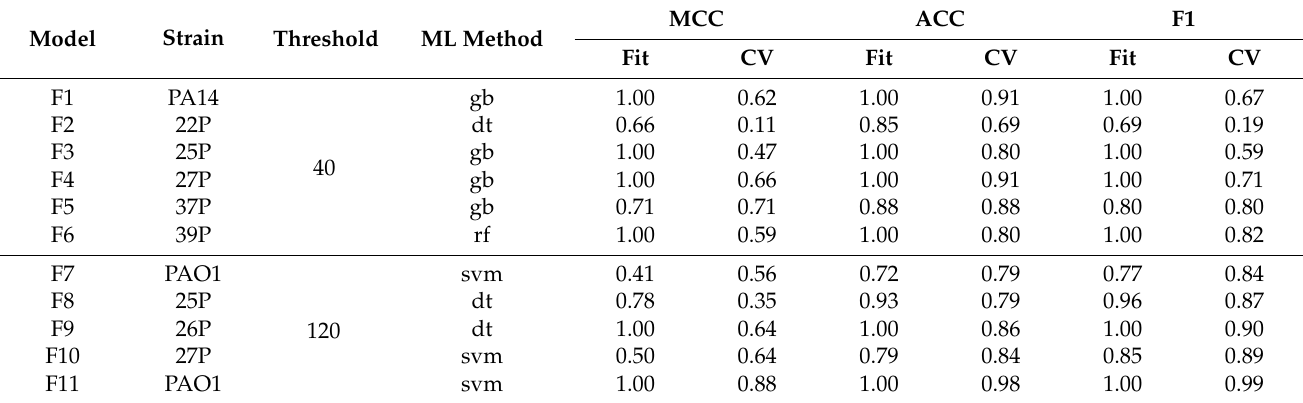
Table 2. Optimized final models obtained with 100 random iterations of data augmentation.